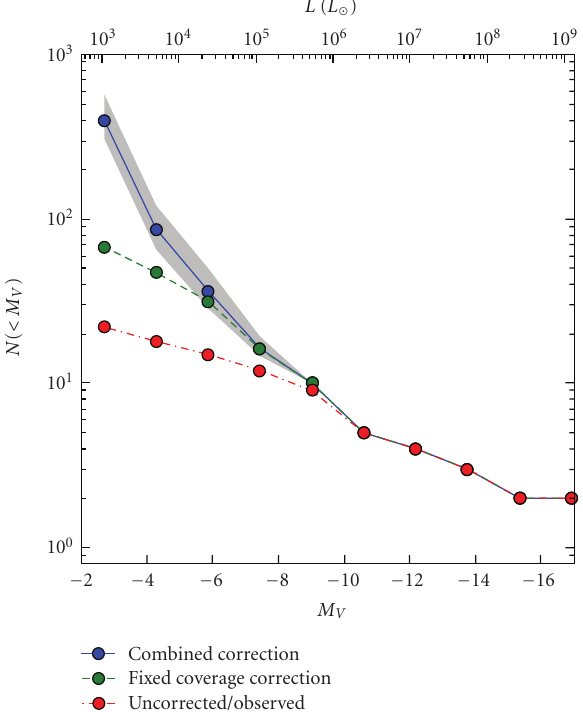
Figure 6: The luminosity function of dwarf galaxies around the Milky Way. The function includes all observed galaxies within 417 kpc of the Milky Way. The red circles connected by the dotted line show the luminosity function as observed, without any corrections for incompleteness. The green circles connected by the dashed line show the observed luminosity function corrected for limited area coverage of surveys on the sky. The blue circles connected by the solid line show luminosity function corrected for the radial bias using radial distribution of subhalos from the Via Lactea I simulation. Adopted from